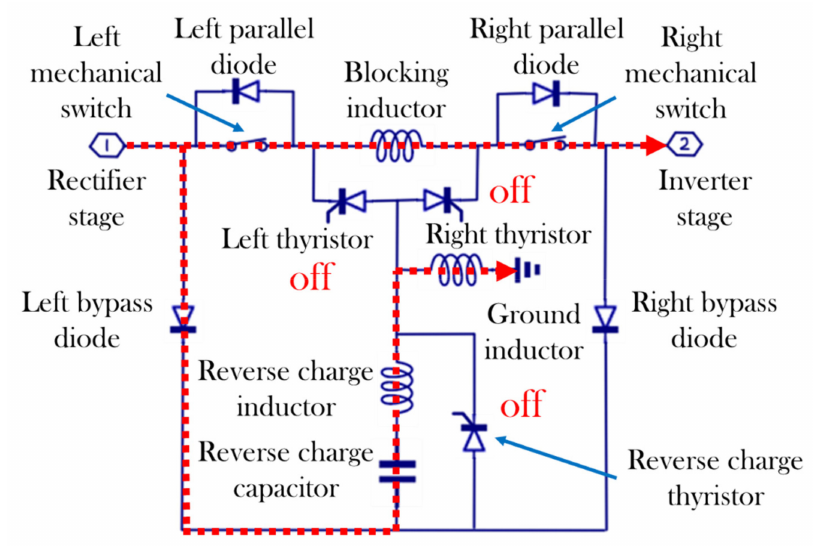
Figure 1. The overall circuit diagram of the DCCB proposed in this paper and the steady-state current